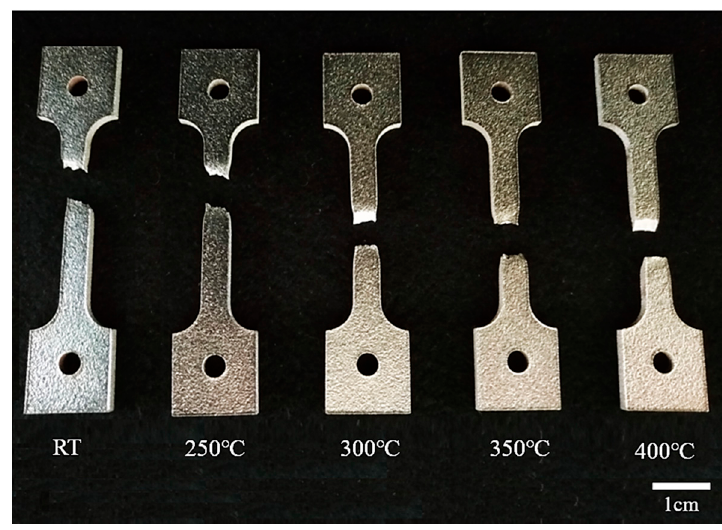
Figure 10. Macroscopic morphology photographs of room temperature and high temperature tensile fracture specimens.